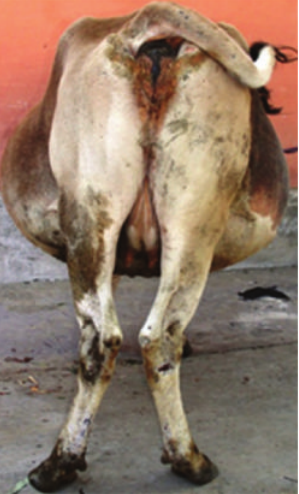
Figure 2: Classic pear-shaped abdomen, indicative of ascites, in a Jersey cross-bred cow with